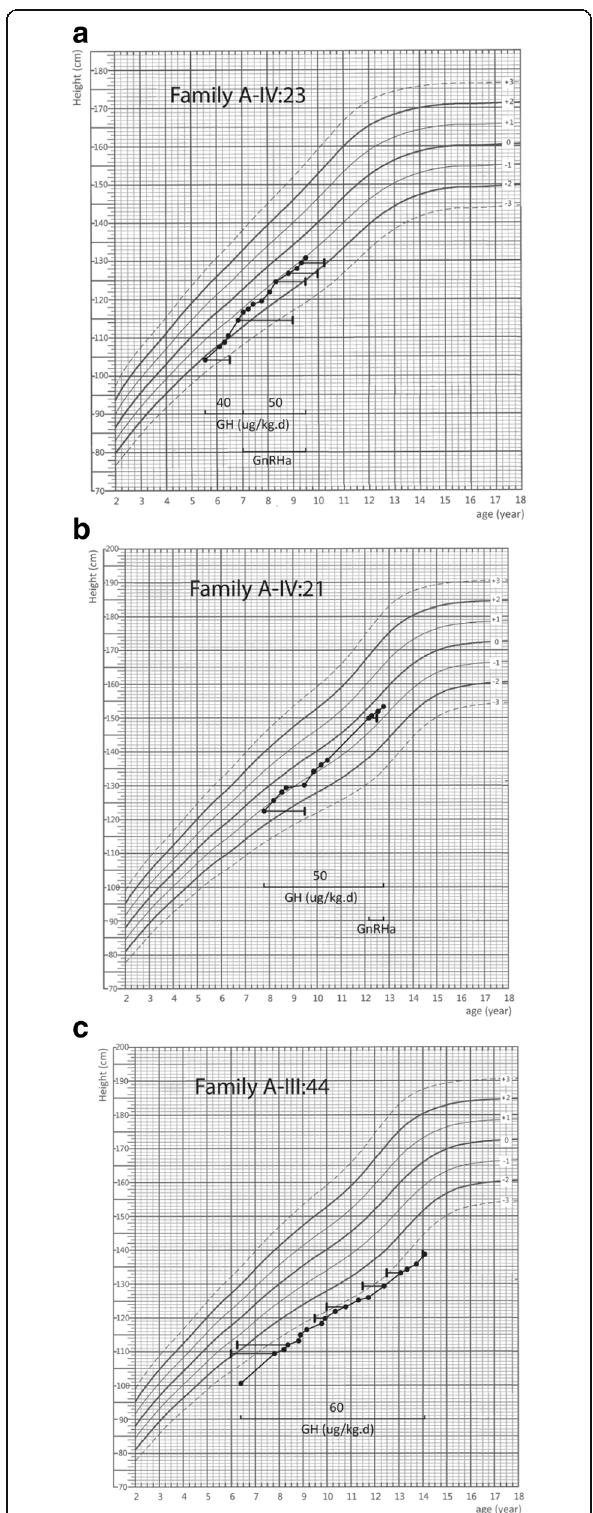
Fig. 3 Growth charts of patients with the ACAN p. Gln2364Pro variant. Vertical bars represent bone age. GH; growth hormone. GnRHa; gonadotropin releasing hormone analog